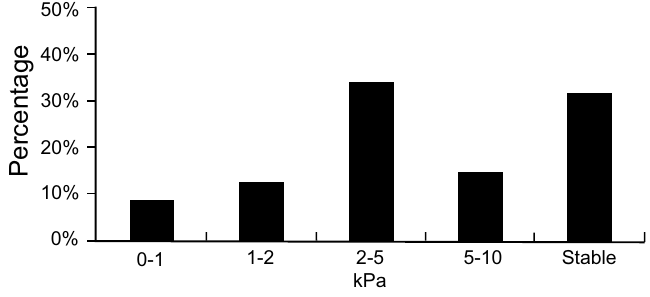
Figure 9. Percentage of the total area of the 46 mapped landslide scars by cohesion class.